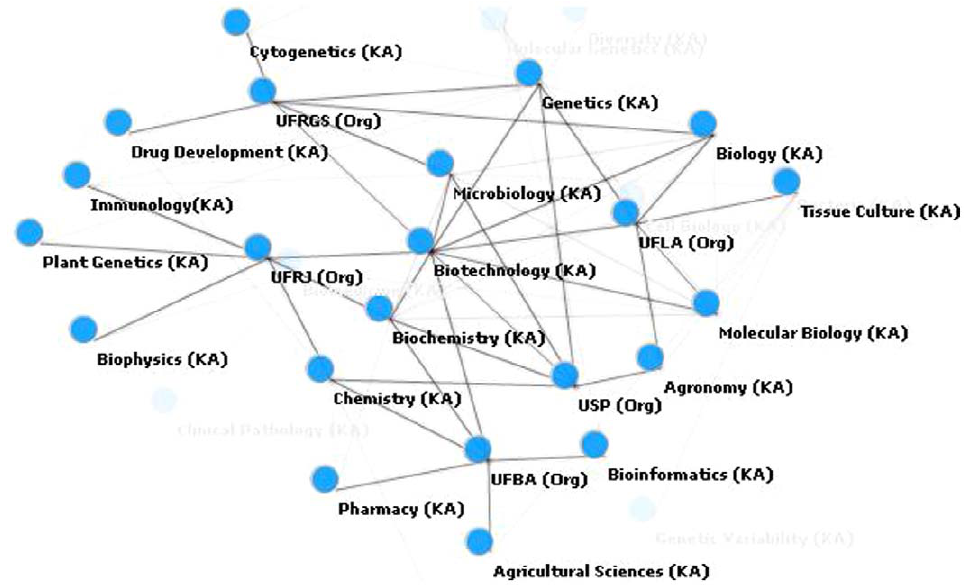
Figure 8. Network graphic based on knowledge area (KA) and organization (Org) entities for the biotechnology instance.